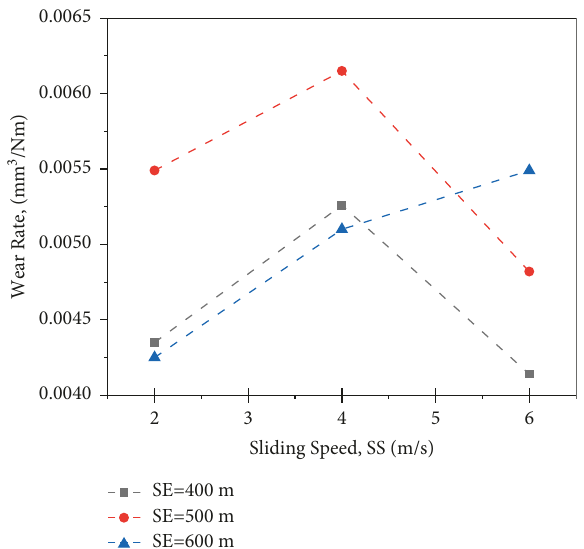
Figure 5: Interaction between SS and SE levels at LD � 50N.